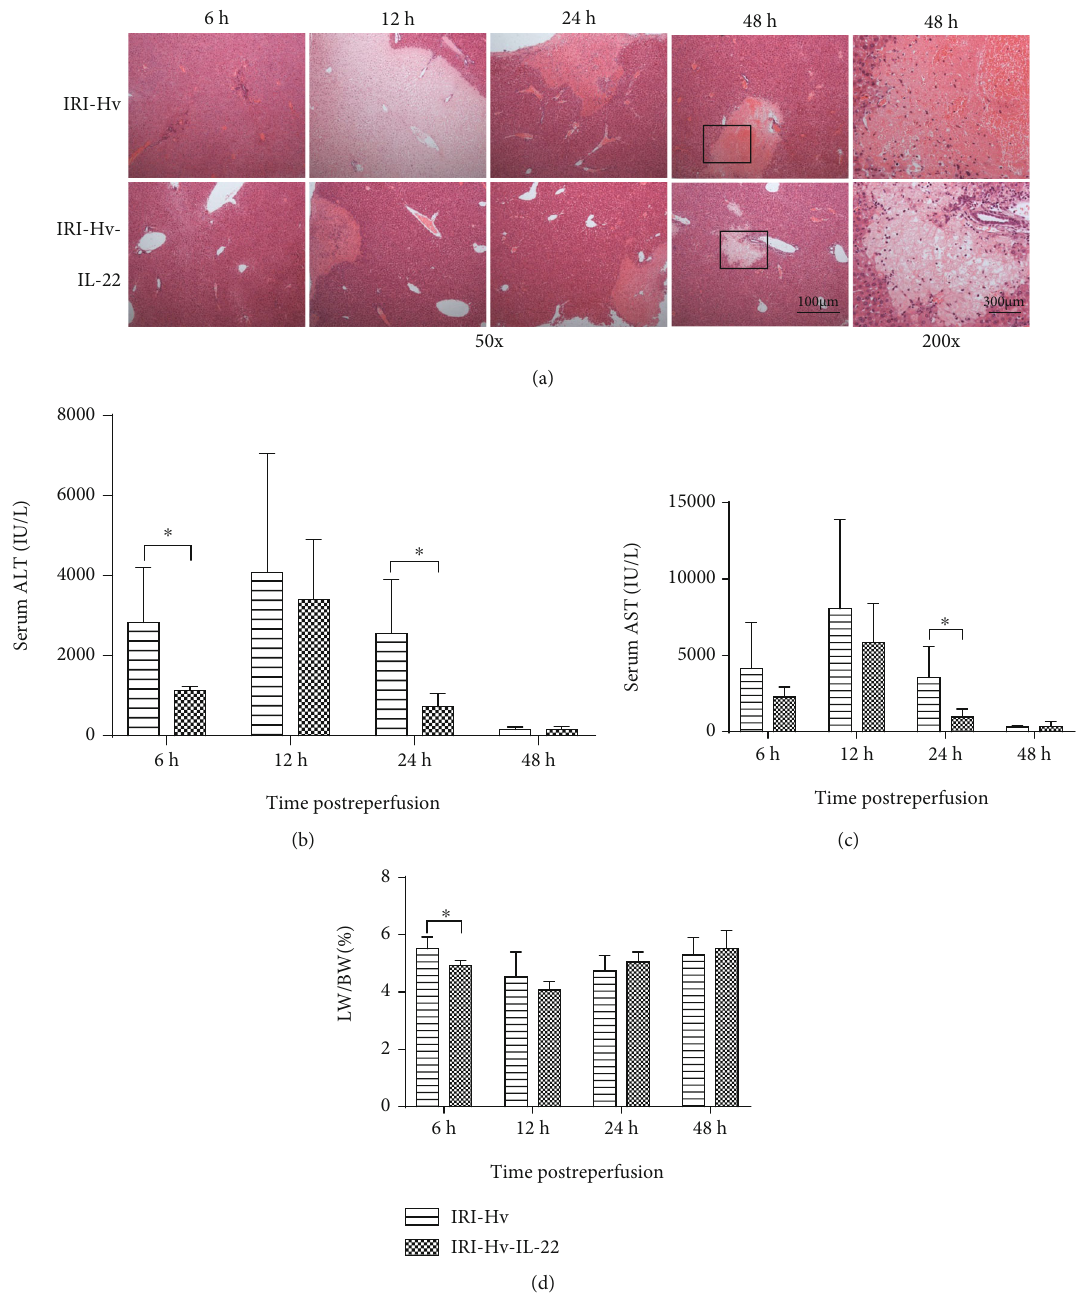
Figure 5: Administration of exogenous IL-22 recombinant protein reduces liver injury induced by IR. (a) H&E-stained liver sections show that the IRI-Hv group had larger infarct areas than the IRI-Hv-IL-22 group. (b, c) Serum ALT and AST concentrations in the IRI-Hv group were higher than those in the IRI-Hv-IL-22 group at several time points. (d) LW/BW ratios of the two groups at di ff erent time points after reperfusion ( n = 4 ‐ 6 , ∗ p < 0 : 05